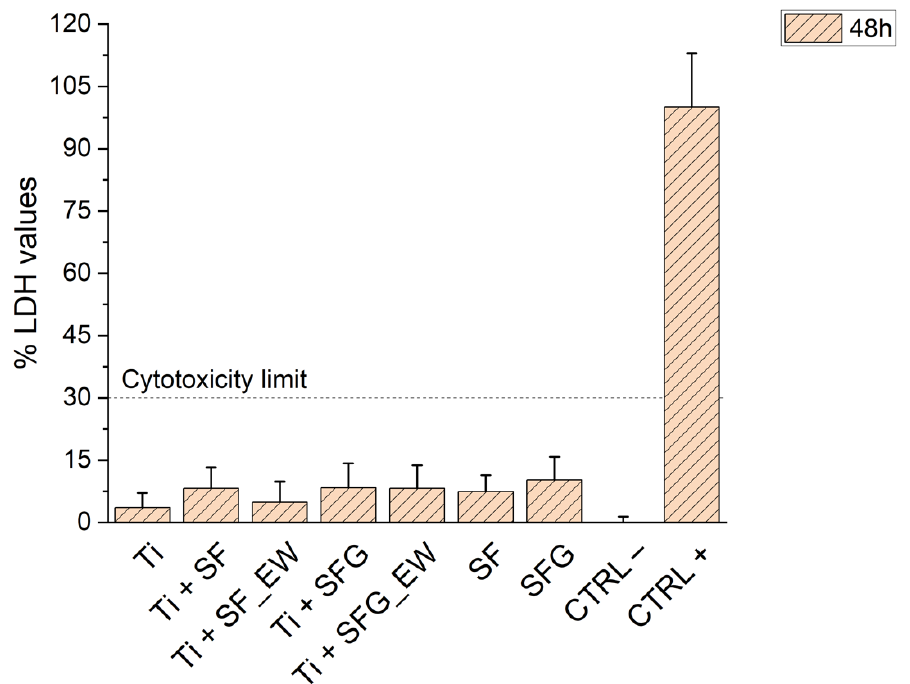
Figure 9. The bar plots reporting the %LDH values against the different conditions tested. Two controls, positive (CTRL+) and negative (CTRL − ), were also reported. The evaluated conditions are the bare titanium cage (Ti), the four previously investigated composite conditions (herein classified as Ti + SF, Ti + SF_EW, Ti + SFG, and Ti + SFG_EW), and two stand-alone foams, namely one of pure silk fibroin (SF) and one of the blended compositions at a volume ratio of gelatin-silk fibroin 1:4 (SFG). The dashed line indicates the threshold limit below which the sample is not considered cyto- toxic.